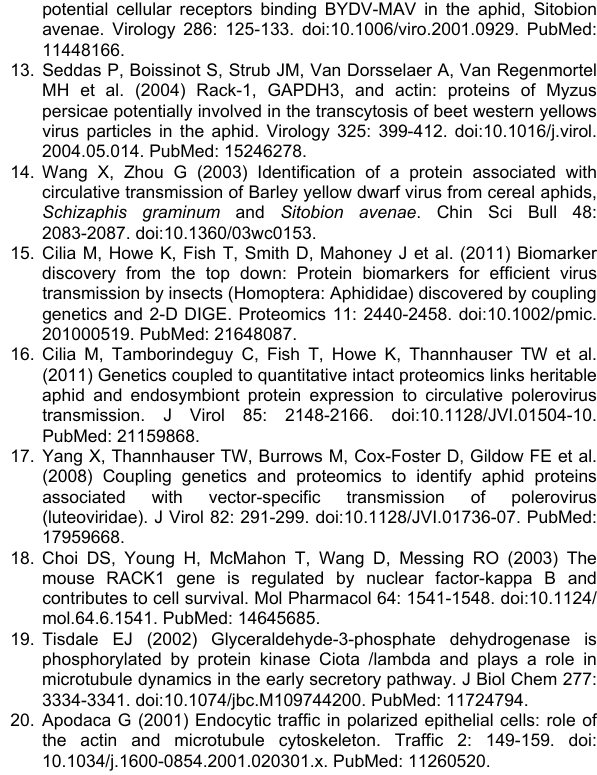
Figure S3. Tandem mass spectra and retention times for two peptides used in label-free quantification of cyclophilin in aphid-virus co-immunoprecipitation reactions. The doubly charged, fully tryptic peptide FFDMTAFGEQLR was selected for tandem MS at retention times 41.3-41.5 min (A). Retention time CV is 0.2% (B). The